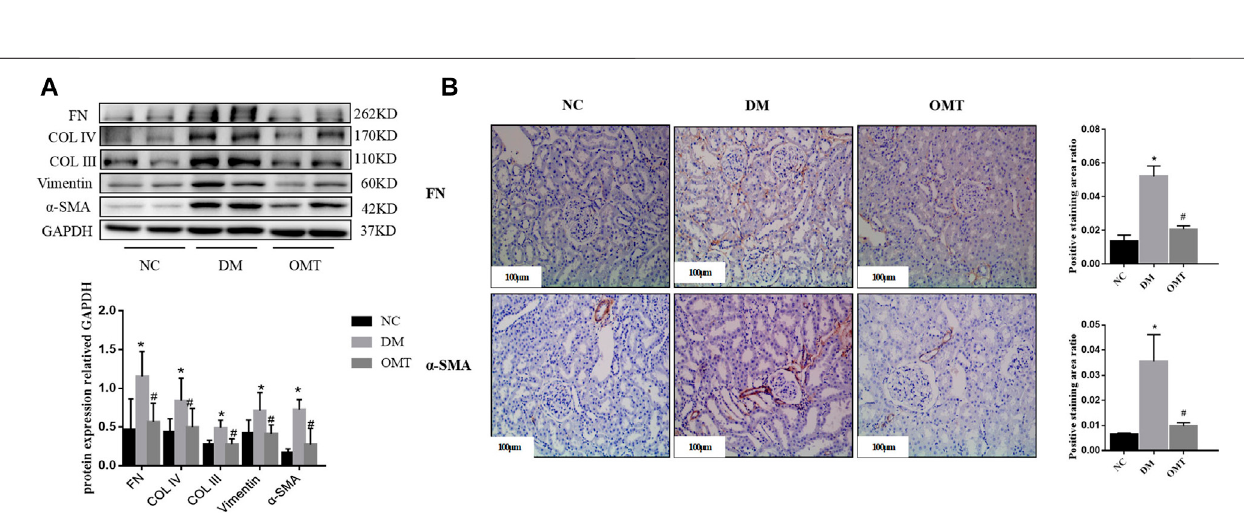
FIGURE 9 | Detection of fi brosis changes after OMT treatment in vivo . (A) Changes in the expression of EMT and ECM-related indicators in the normal control group, diabetes model group, OMT intervention group, * p < 0.05 vs. NC group, # p < 0.05 vs. DM group (B) Immunohistochemical technology was used to detect the